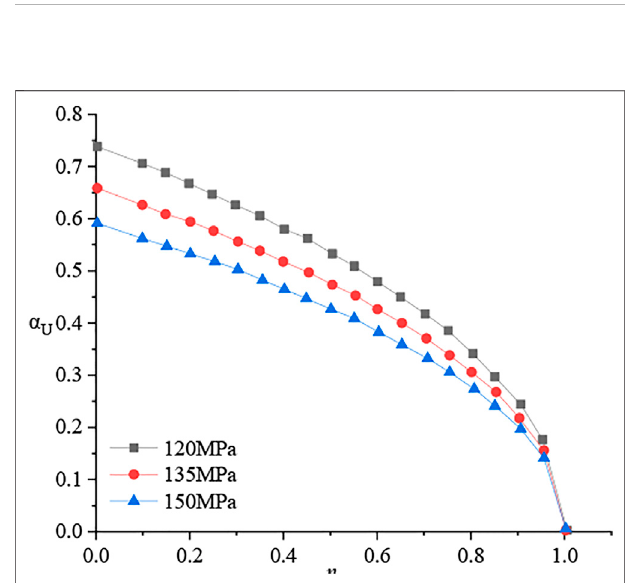
FIGURE 14 | In fl uence of η on α U .